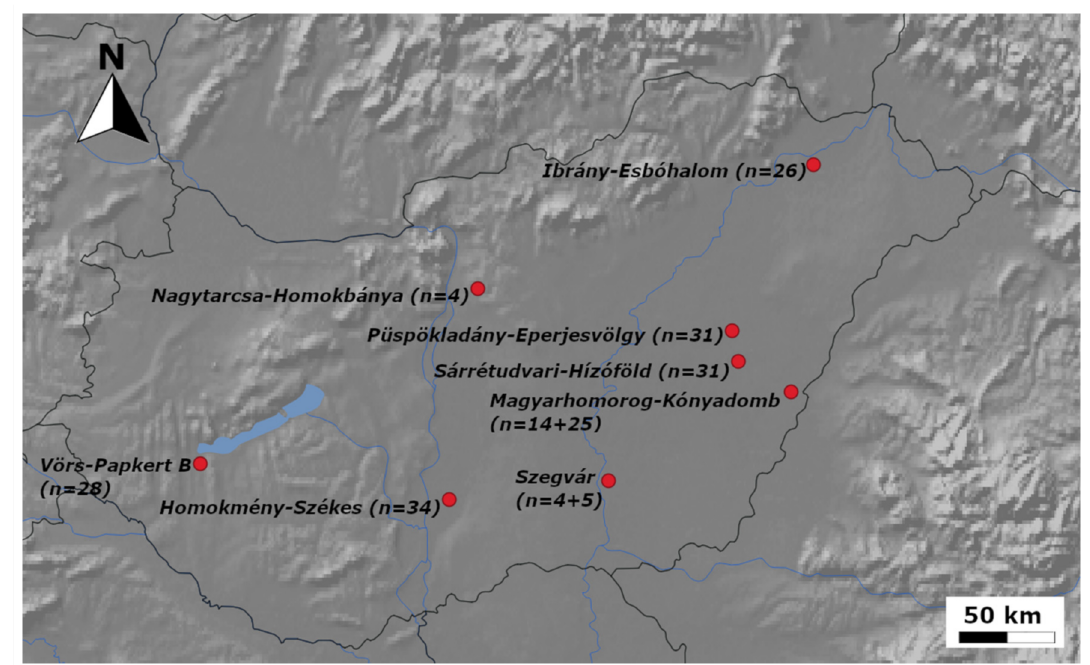
Figure 1. The locations of the graveyards of the Hungarian commoners (ConqC) under study. Sample size is indicated next to cemetery names; two numbers in Magyarhomorog and Szegv á r indicate that two nearby cemeteries were sampled. The map was generated using QGIS 3.12.0 [10].